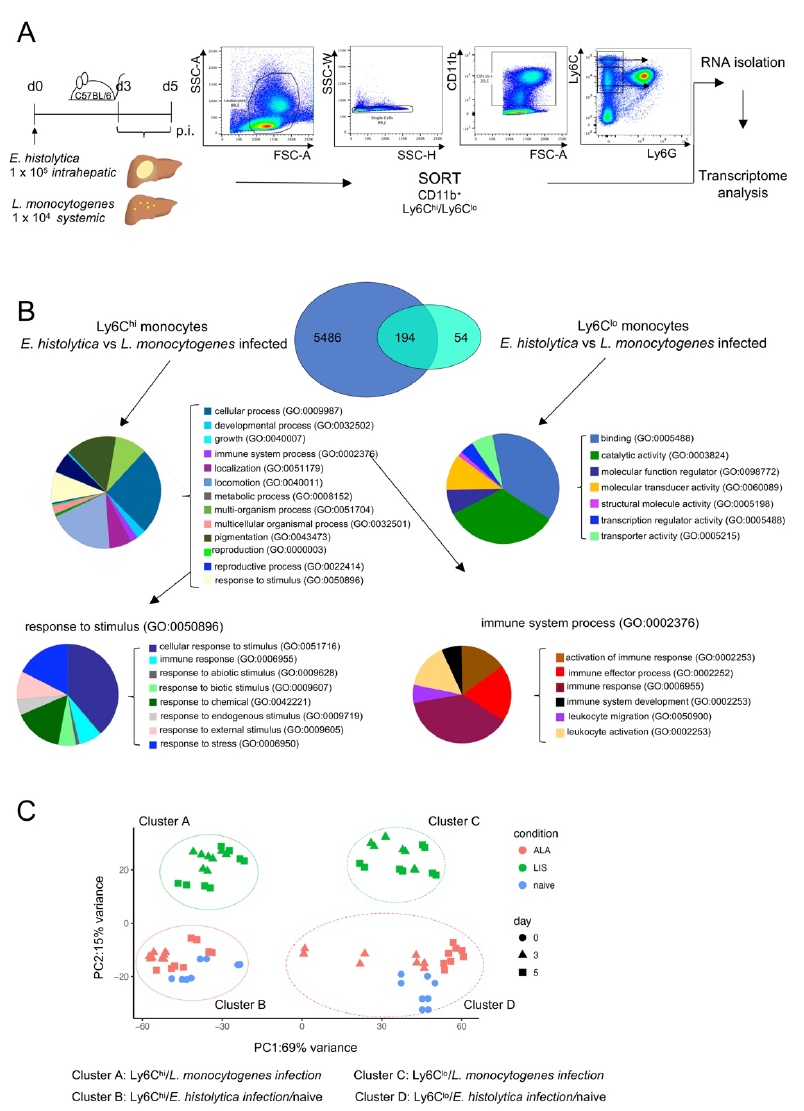
Figure 2. Transcriptome analysis of monocytes from the livers of mice infected with E. histolytica or L. monocytogenes. ( A ) Gating and mRNA purification strategy for liver-specific Ly6C hi and Ly6C lo monocytes from E. histolytica- and L. monocytogenes -infected mice. ( B ) VENN diagram of transcriptome analysis of Ly6C hi and Ly6C lo monocytes shows significantly regulated genes of Ly6C hi and Ly6C lo monocytes from both infection models. PANTHER GO-slim analysis was performed to identify biological pathways involving significantly regulated genes in both monocyte populations. ( C ) Principal component analysis of transcriptomic data from Ly6C hi and Ly6C lo monocytes from naïve and E. histolytica- and L. monocytogenes -infected mice. monocytes obtained from the two infection models at d3 p.i. were included in the analysis. 5486 genes were differentially expressed in Ly6C hi monocytes from E. histolytica- and L.